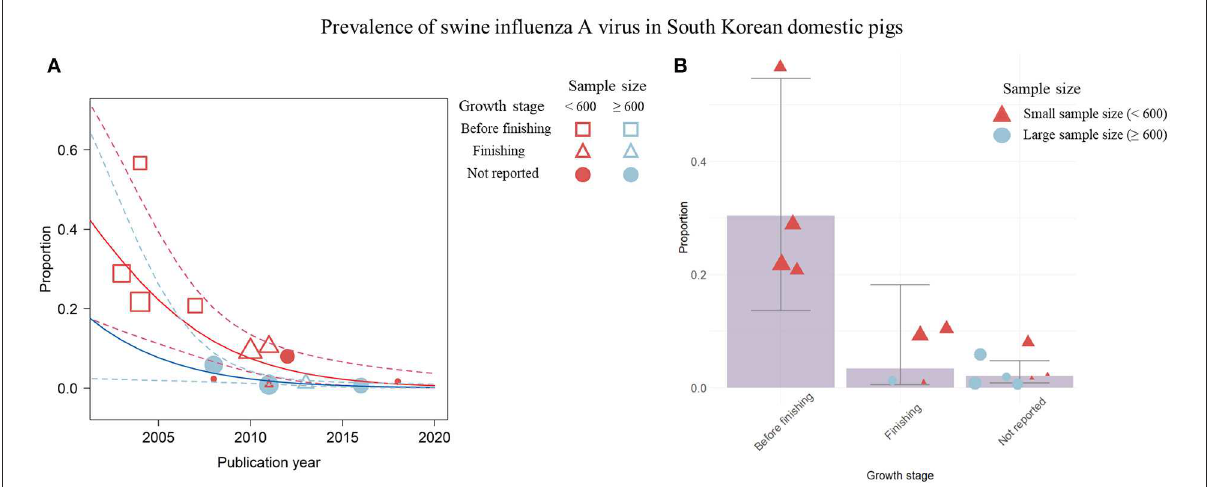
FIGURE5 Visualization of the prevalence data for swine influenza A virus (swIAV) by the significant covariates; publication year, sample size, and growth stage of pigs. (A) Change in swIAV prevalence according to the publication year visualized by a weighted scatter plot. Solid red line denotes the regression describing association among the prevalence, the small sample size, and the publication year. Solid blue line indicates regression depicting the relationship among the prevalence, the large sample size, and the publication year. Dashed lines show 95% CIs of the regression model. (B) swIAV seroprevalence proportion by each growth stage using the bar plot. Circles or triangles indicate individual studies and the size of the figures corresponds to the weighted average of effect size of each study. The sample size is represented by red (small) and blue (large) colors. Error bar represents 95% CIs.